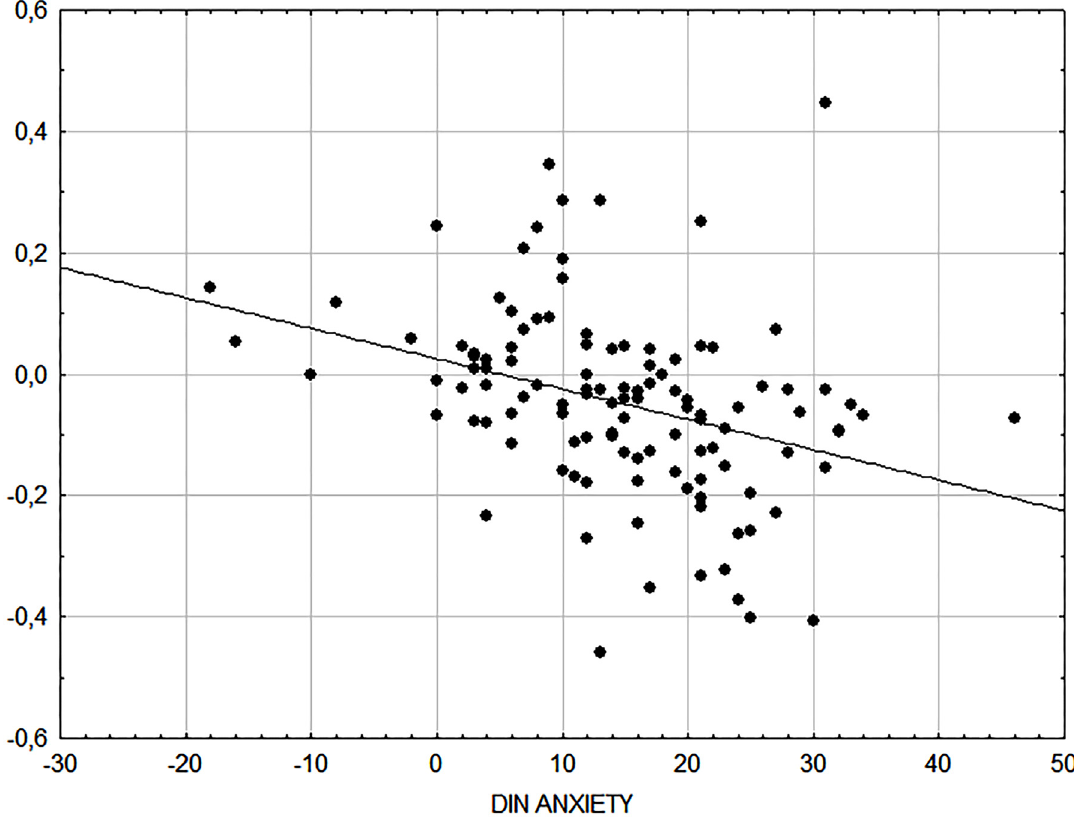
Fig 4. Correlation between the dynamics of state anxiety (DYN SA = SA at exam − SA at rest) and Largest Lyapunov exponent (LLE; DIN LLE = LLE at exam − LLE at